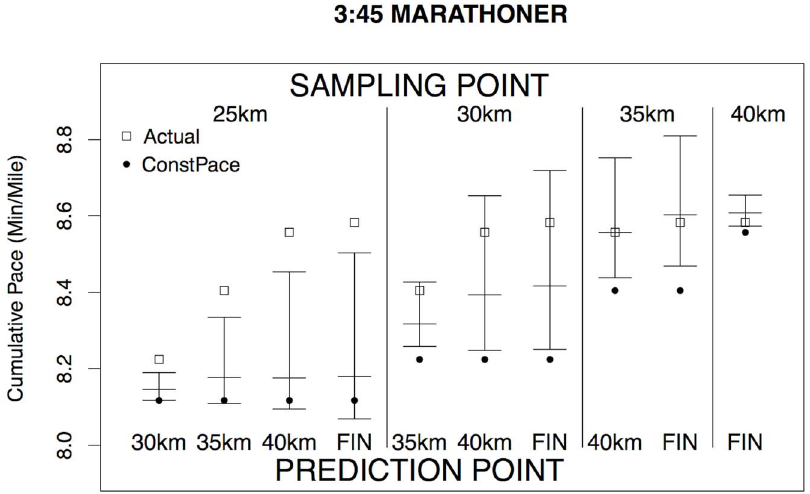
Figure 10. Comparison of Predicted and Actual Pace II. Similar to Fig. 9 but for a 3:45 marathoner.